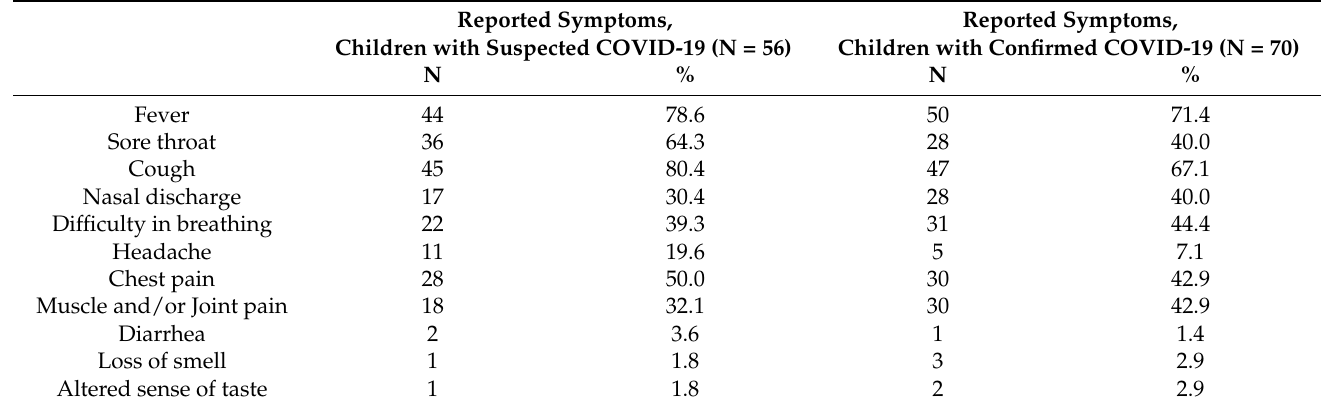
Table 4. Symptoms of Children, Age 18 or below, with Suspected and Confirmed COVID-19 Infection.